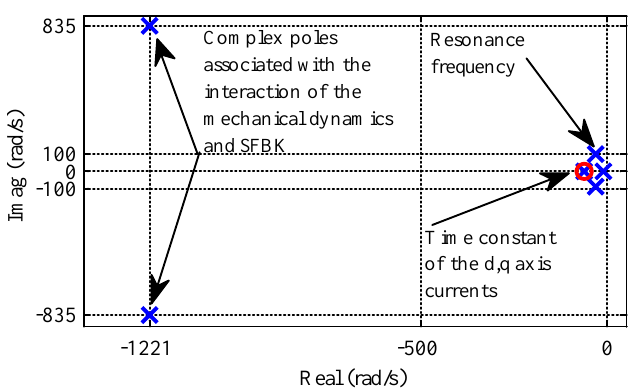
Figure 9. Poles and zeros distribution